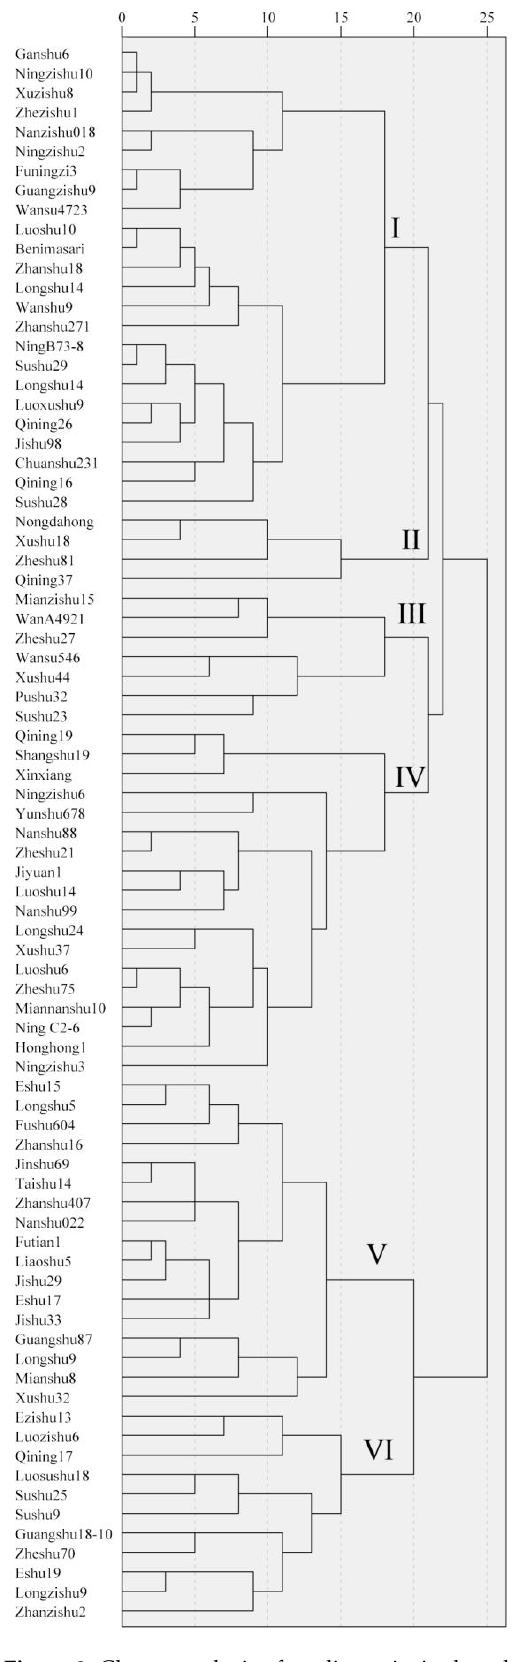
Figure 2. Cluster analysis of quality traits in the tuberous roots of 81 sweet potato varieties. Roman numerals I to VI indicate six groups.